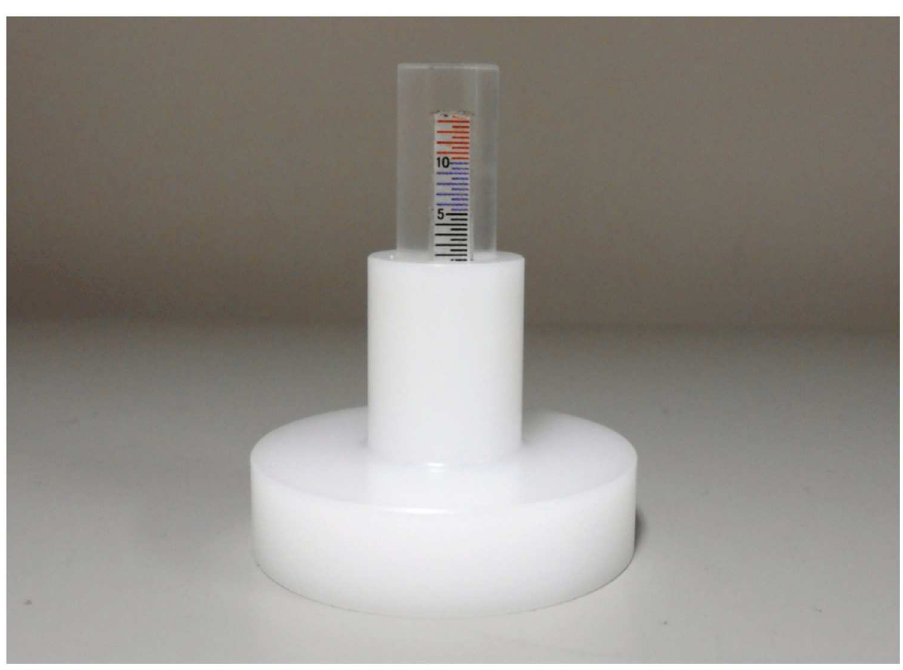
Fig 1. Measurement